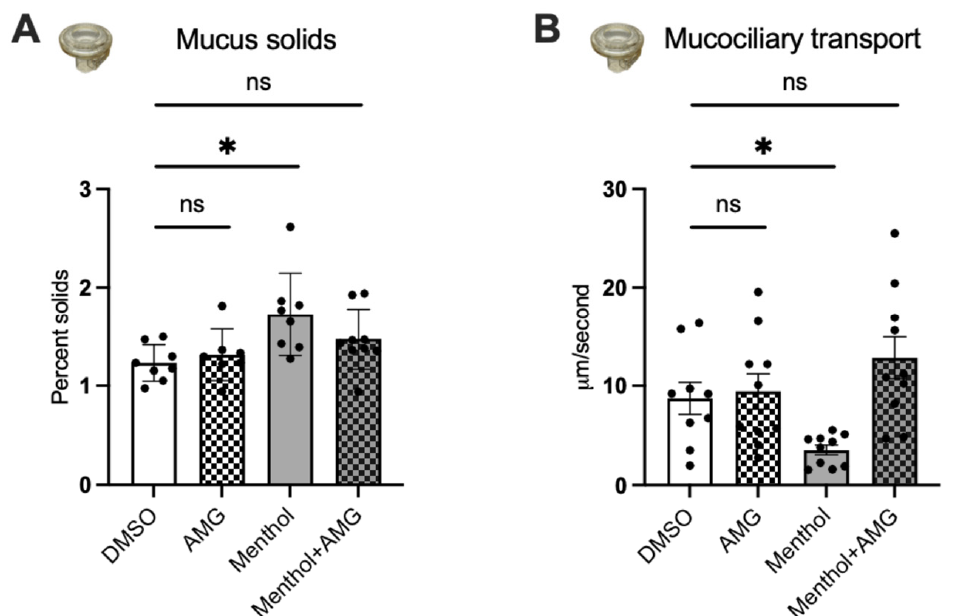
Figure 6. Effects of a TRPM8 antagonist on menthol-induced reductions in parameters of MCC. All measurements were recorded 24 h after nebulization of DMSO (~0.1% final in the ASL, control) and menthol (~1 mM) with or without AMG333 (~100 nM final in the ASL, and 100 nM in the basolateral media). ( A ) Percent mucus solids measured using a mesh. n ≥ 8 from 4 lungs. ( B ) Mucociliary transport measured with fluorescent beads. n ≥ 9 from 4 lungs. Statistics: Data shown as mean ± SEM. * p < 0.05 compared to DMSO control, two–way ANOVA followed by Dunnett ( A ) and one-way ANOVA followed by Dunnett ( B ).